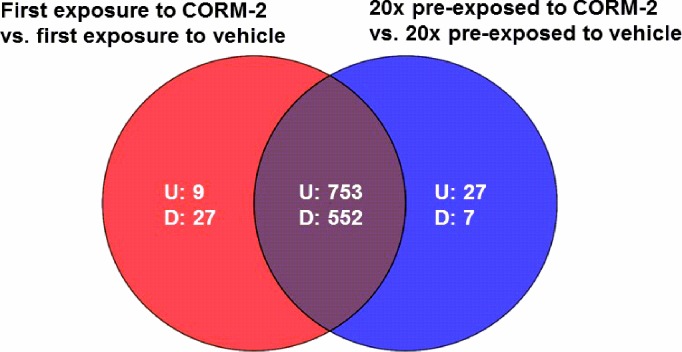
Venn diagram of differently expressed entities in ESBL isolate 7.Shown in red, first-time exposure to CORM-2 (250 μM) versus first-time exposure to vehicle (2.5% DMSO); in blue, pre-exposed 20 times to CORM-2 versus pre-exposed 20 times to vehicle. Up- and down-regulated entities are designated U and D respectively (n = 4 in each group). Overlapping regions represent entities present in both experimental conditions.